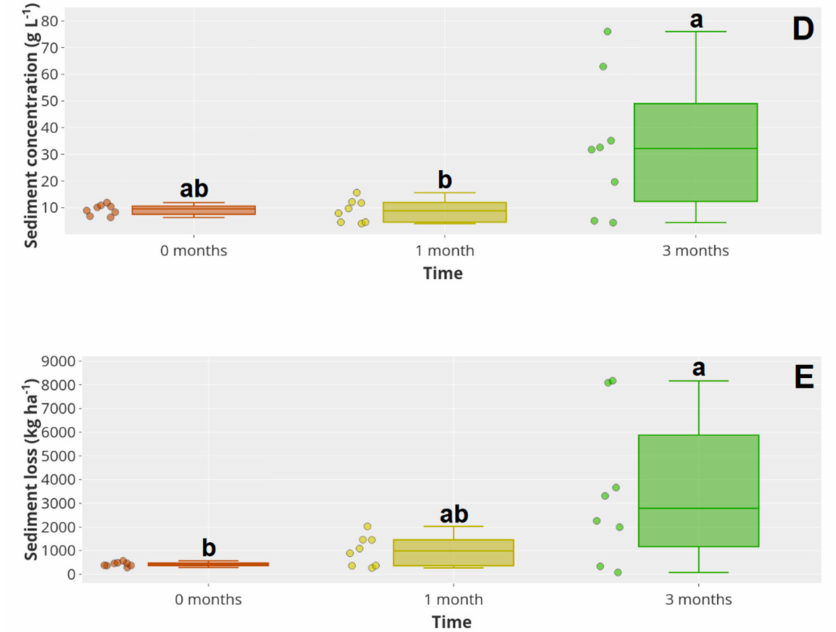
Figure 5. Hydrological response over the study period: ( A ) time to ponding, ( B ) time to runo ff , ( C ) water runo ff , ( D ) sediment concentration, and ( E ) sediment loss distribution according to the time after tillage. Upper hanging bar (maximum), lower hanging bar (minimum), upper box line (quartile 3), line (median), and lower box line (quartile 1). Di ff erent lower-case letters represent significant di ff erences between treatments ( p < 0.05). Dots next to a boxplot represent measured values.